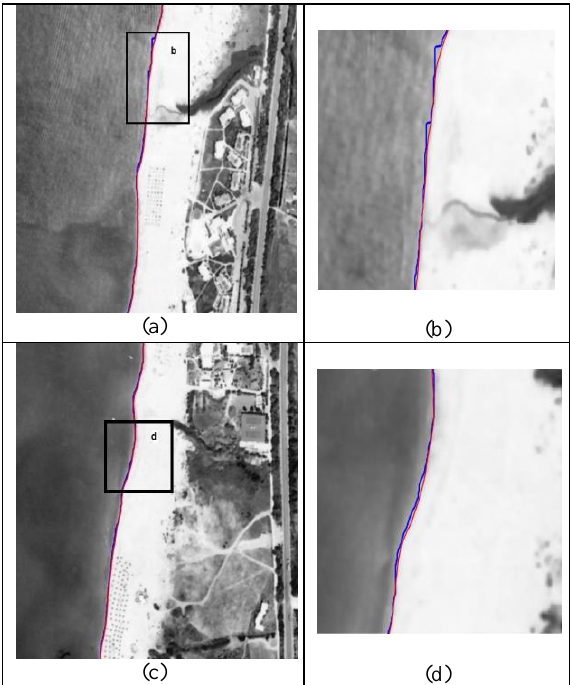
Figure 6. Estimation of second approach: (a), (c) close-up of the initial image in two different locations showing the results of the two methods. Blue line refers to the estimated coastline extracted from the first approach while red line refers to the optimized coastline obtained from the second approach; (b), (d) provide a more detailed aspect of (a), (c) respectively in order to have a better understanding of the improvement of the coastline